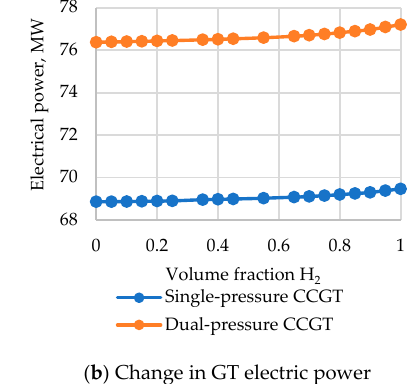
Figure 12. Dependence of the temperature of the working fluid and the output power on the hydrogen volume fraction.